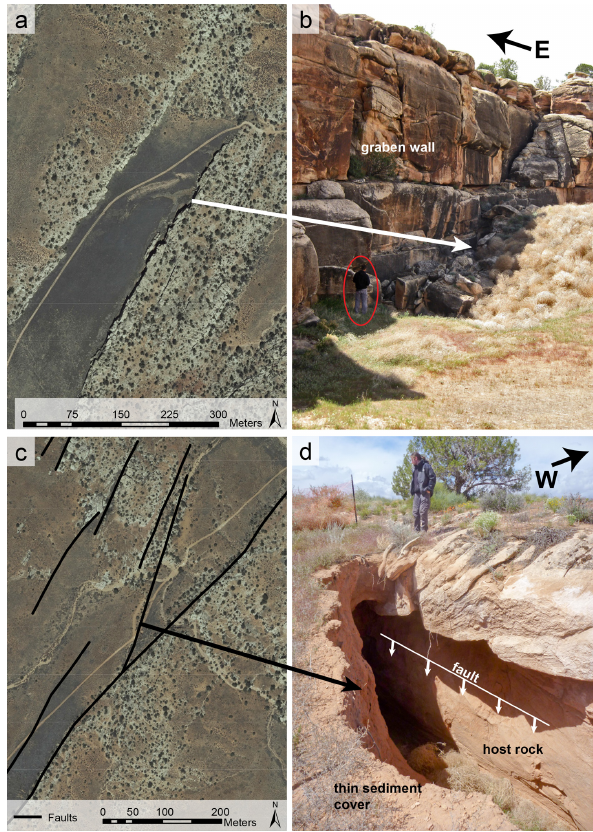
Figure 5. (a) Aerial photograph showing the location and surface depression of a large sinkhole (cf. arrow “1” in Fig. 3). (b) Field photograph showing the same sinkhole (person in the ellipse for scale). Material is lost into a cavity or an interconnected system of open fractures allowing an outflow of sediments in the subsurface. (c) Airborne photograph showing location of another sinkhole not located at a graben wall (cf. arrow “2” in Fig. 3) but at a graben- crossing fault. (d) Corresponding field photograph illustrating open gap at fault.